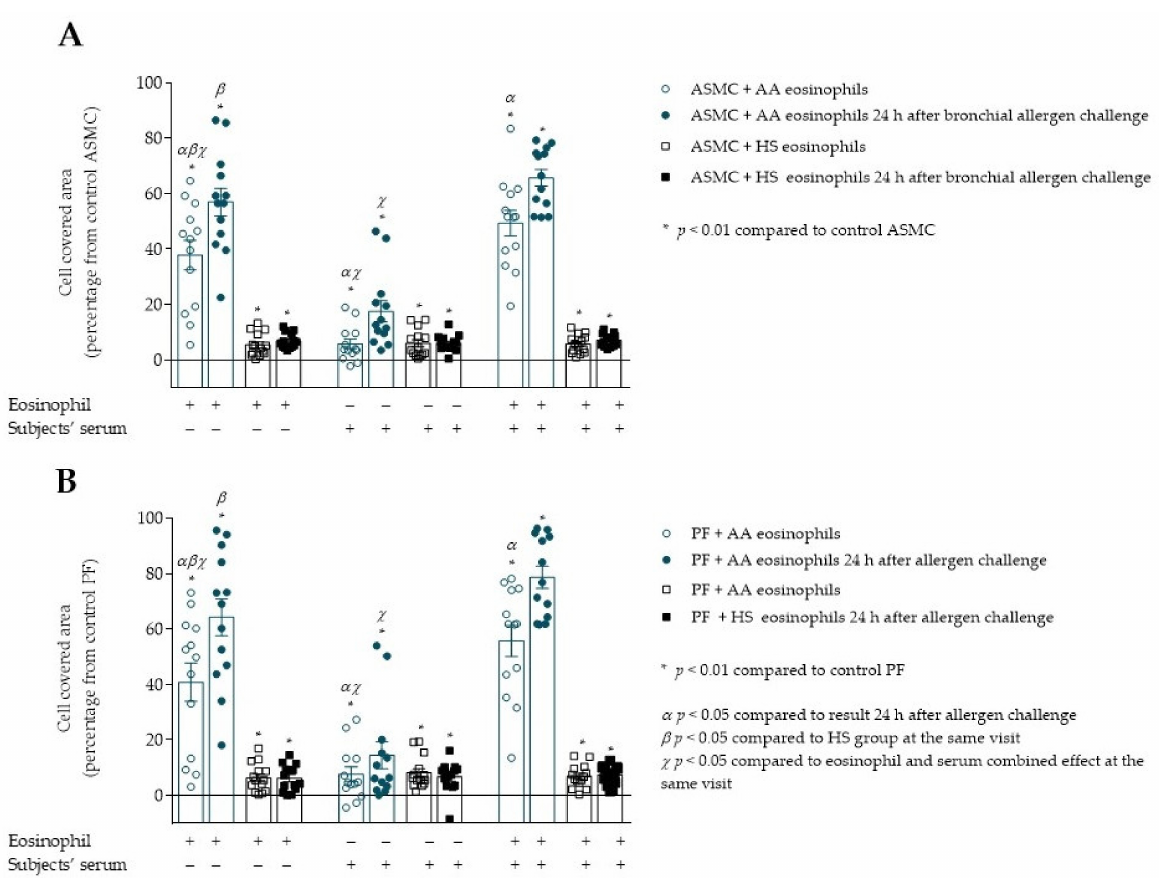
Figure 9. ( A )–Migration of ASMC after incubation with allergen-activated eosinophils and/or subjects’ serum. ( B )–Migration of PF after incubation with allergen-activated eosinophils and/or subjects’ serum. Data presented as cell covered area, as a percentage of control cells. Added blood serum of each investigated subject to individual combined cultures: 2% v / v . AA n = 13; HS n = 14. AA—allergic asthma; ASMC—airway smooth muscle cells; HS—healthy subject; PF—pulmonary fibroblast. α — p < 0.05 compared to results 24h after allergen challenge; β — p < 0.05 compared to the only serum effect at the same visit; χ — p < 0.05 compared to the eosinophil and serum combined effect at the same visit; A—* p < 0.001 compared to control ASMC; B—* p < 0.01 compared to control PF cells. Statistical analysis within one study group—Friedman test for multiple comparison within the group and the post hoc Wilcoxon matched-pairs signed-rank two-sided test (dependent data). Significant differences of ASMC and PF migration were found in AA group 24 h after bronchial allergen challenge by Friedman test, respectively, χ 2 = 17.23, df = 2, p = 0.0002; χ 2 = 18.00, df = 2, p = 0.0001. The results from Figure 6A,B of AA and HS patients were re-used as the baseline (before allergen challenge) result. 3.7. The Effect of Allergen-Activated Eosinophils on Gene Expression in ASMC and